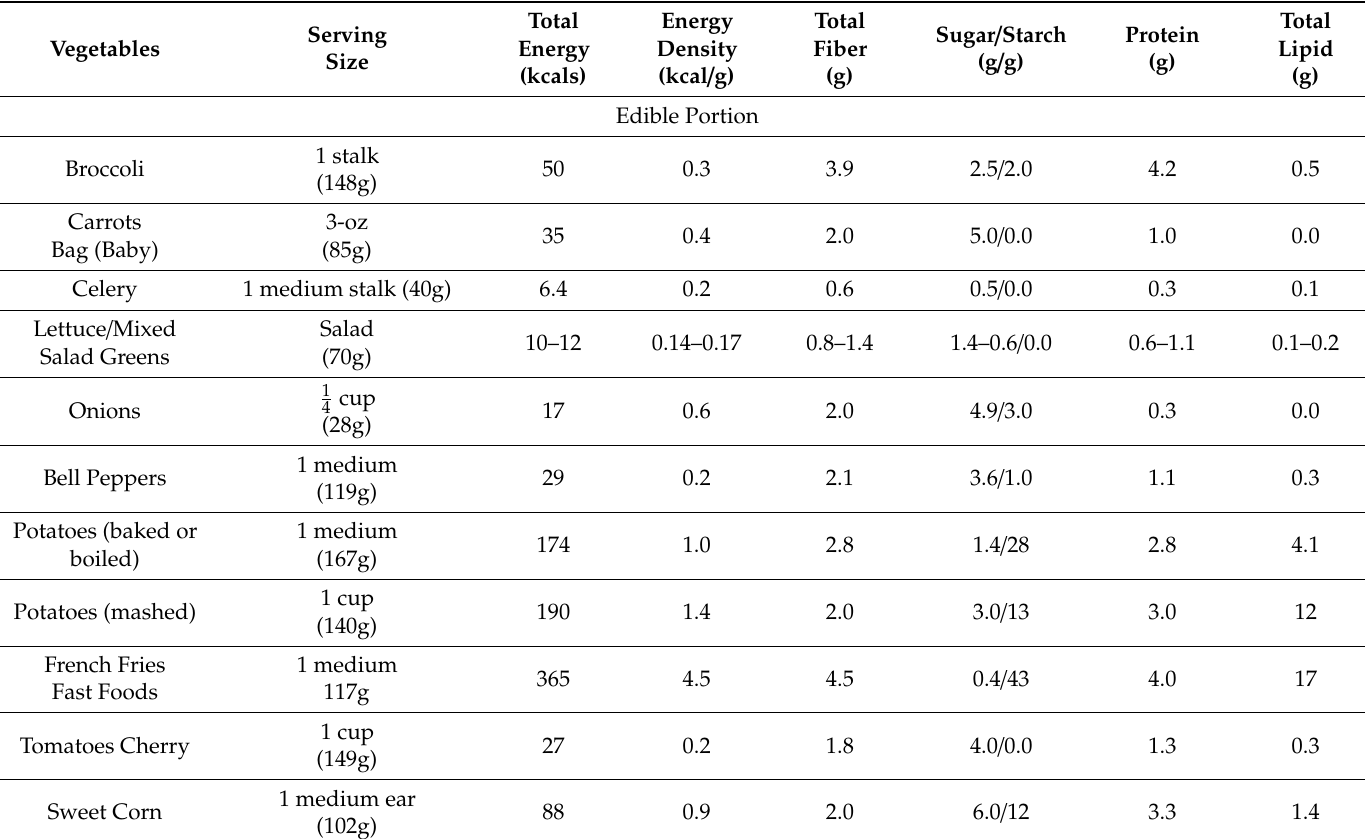
Table A3. Top ten most consumed vegetables in the US and their nutrition components per serving, which are generally associated with weight management [84].